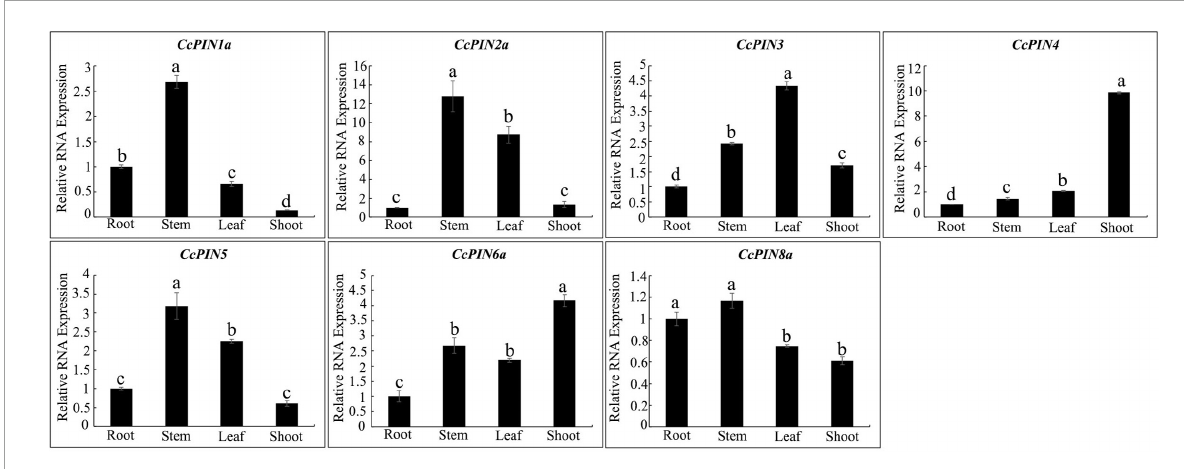
FIGURE7 Tissue-specific expression profiles of CcPIN genes. Total RNA was extracted from roots, stems, leaves, and shoots of 1-year-old Chinese hickory. The relative expression levels of each CcPIN gene in roots were standardized as one. Different letters above the columns denote a significant difference in different tissues ( P < 0.05).